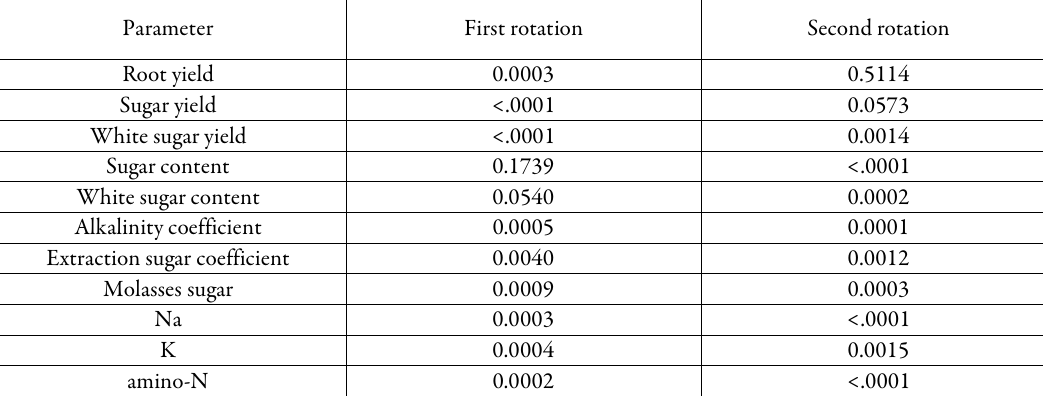
Table 2. Probability values from F-test of fixed effects of first and second rotations on sugar beet cultivars performance and quality